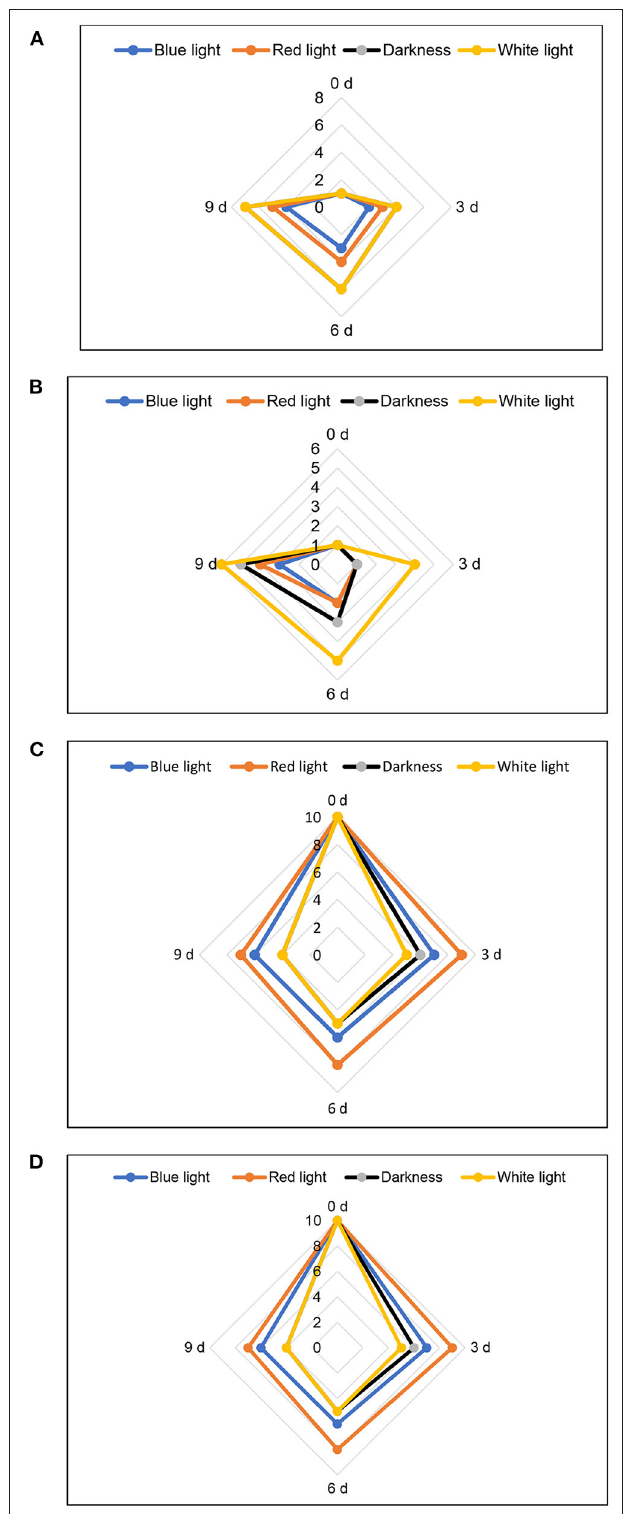
FIGURE 9 | Influence of blue and red LED light treatment on (A) yellowing, (B) shrivelling, (C) typical aroma, and (D) overall acceptability of coriander leaves. For shrivelling and yellowing; 10–9 = very bad 50% unmarketable, 8–7 = poor